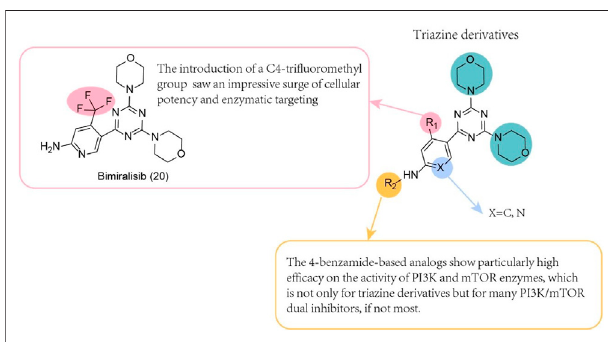
FIGURE 5 | SAR of triazine